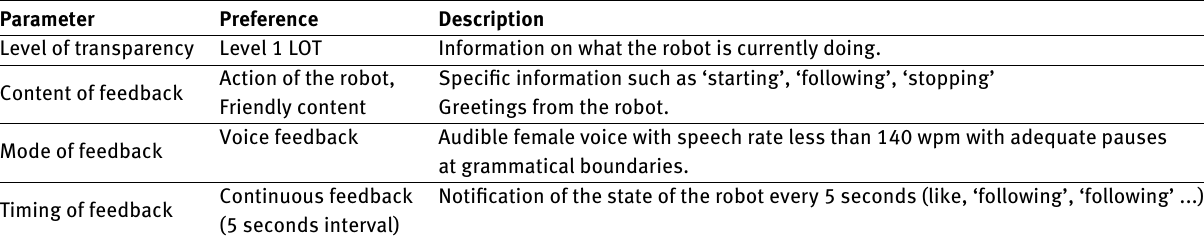
Table 4: Feedback design